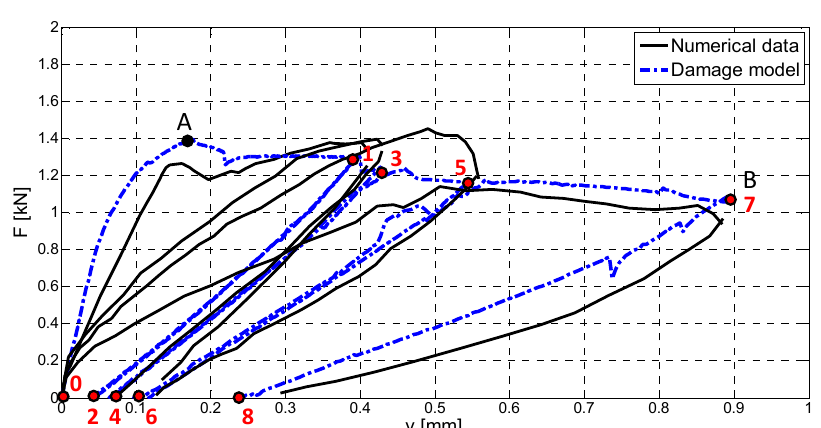
Figure 6: Cyclic test: comparison between numerical and experimental results.